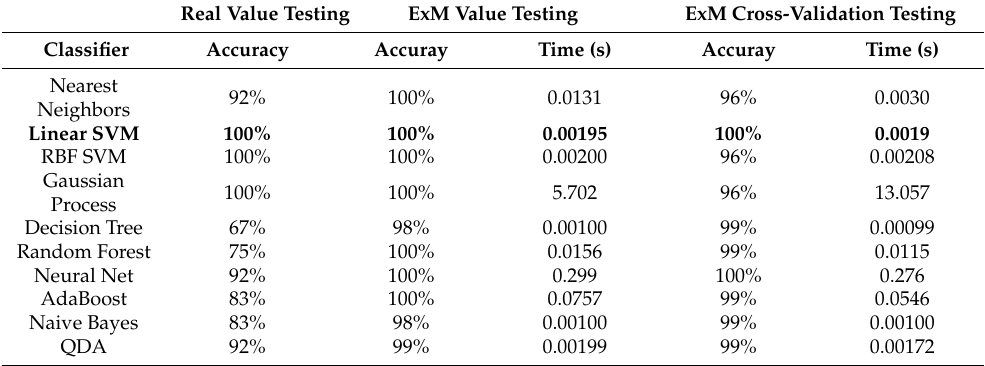
Table 6. Sklearn classifiers accuracy with real volume values, ExM values, and Cross-Validation test.